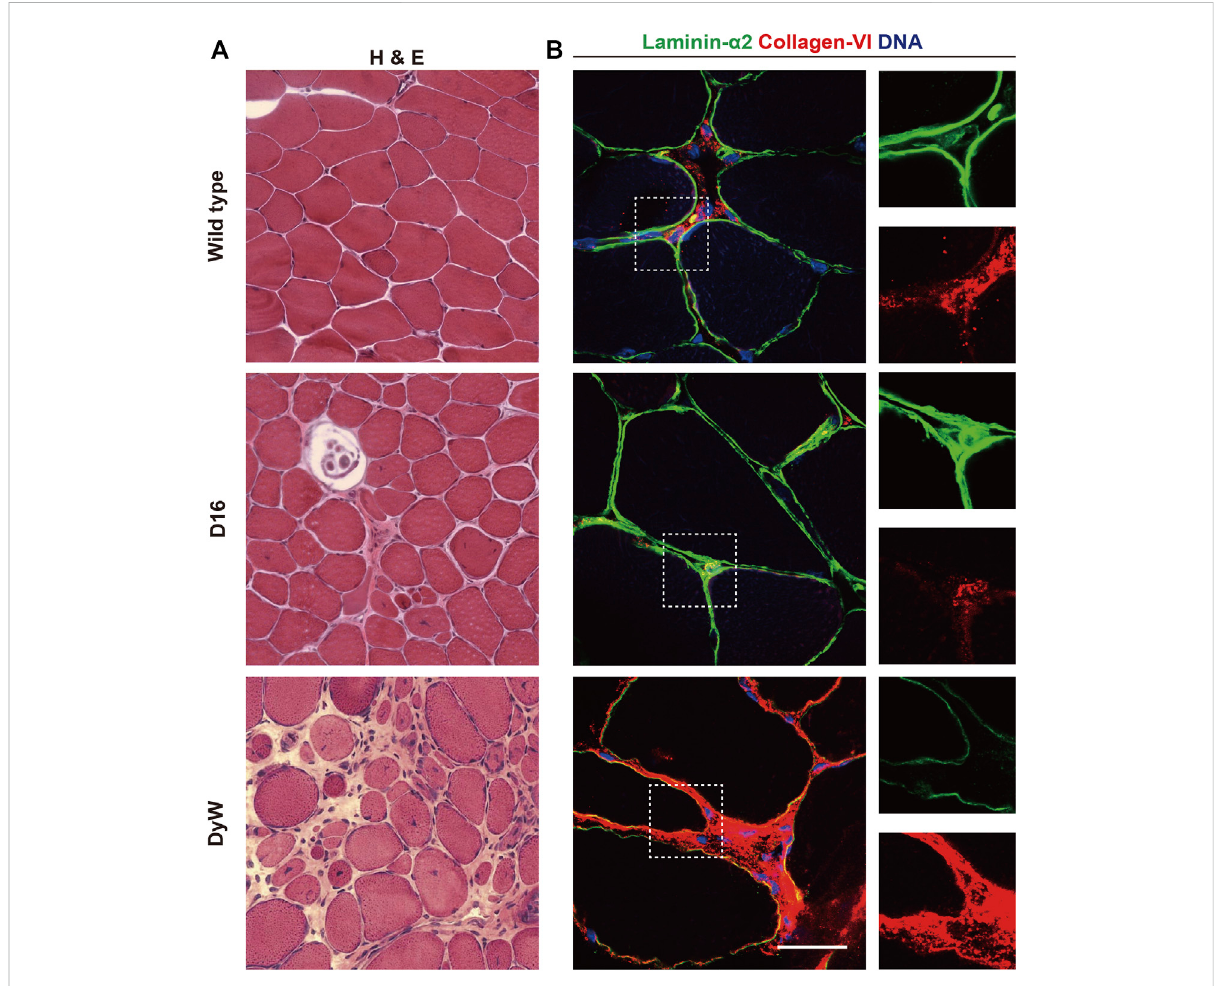
FIGURE 7 ECM and muscular dystrophy. (A) Hematoxylin and eosin (H&E) staining of skeletal muscle sections from wild type mice, COL6A3 mutant D16 mice, and LAMA2 mutant dyW mice (Kuang et al., 1998; Pan et al., 2014). (B) Immunostaining of skeletal muscle cross sections from wild type, D16 and dyW mice showing laminin α 2 (green), collagen VI (red) and DNA